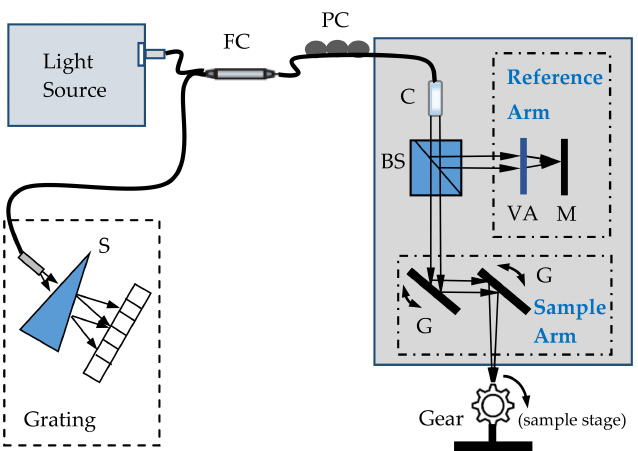
Figure 1. The schematic diagram of the experimental optical coherence tomography (OCT) system. FC: fiber couple; PC: polarization controller; C: collimator; BS: beamsplitter; VA: variable attenuator; M: mirror; SP: spectrograph; G: galvo mirror.